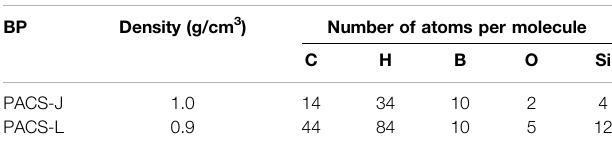
TABLE 2 | Composition of PACS